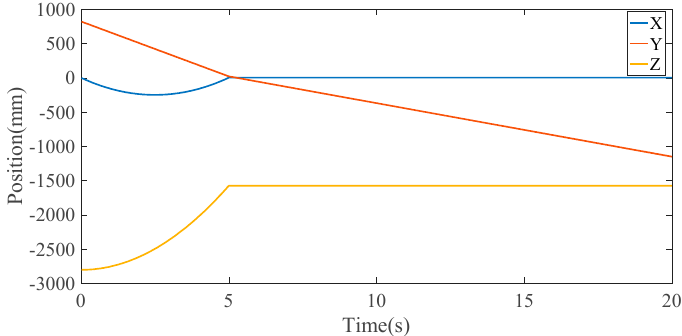
Appl. Sci. 2019 , 9 , x FOR PEER REVIEW Figure 17. The position of the end of the manipulator in the simulation. Figure 17. The position of the end of the manipulator in the simulation.